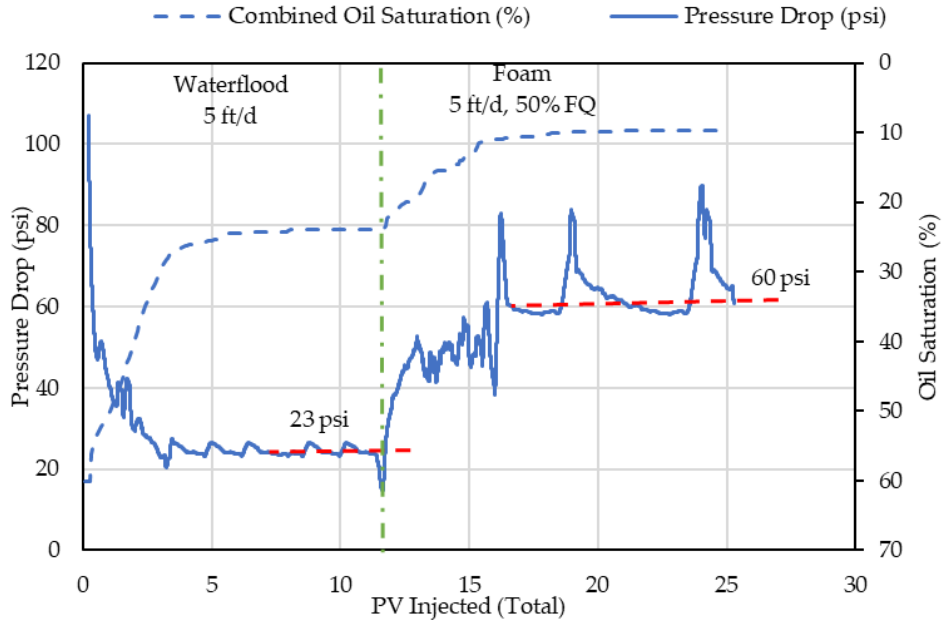
Figure 11. Pressure drop across both cores and the combined oil saturation for DI-Exp 2. Fractional flow and oil recovery from each reservoir unit are shown in Figures 12 and 13, respectively. In Figure 12, fractional flow during the late time waterflood shows nearly 100% injection water penetrating Unit-A. During this stage most of the oil recovery occurs from Unit-A. As shown in Figure 13, 74% of the oil in Unit-A is recovered within 5 PVs, while only 46% of the oil in Unit-B is recovered.